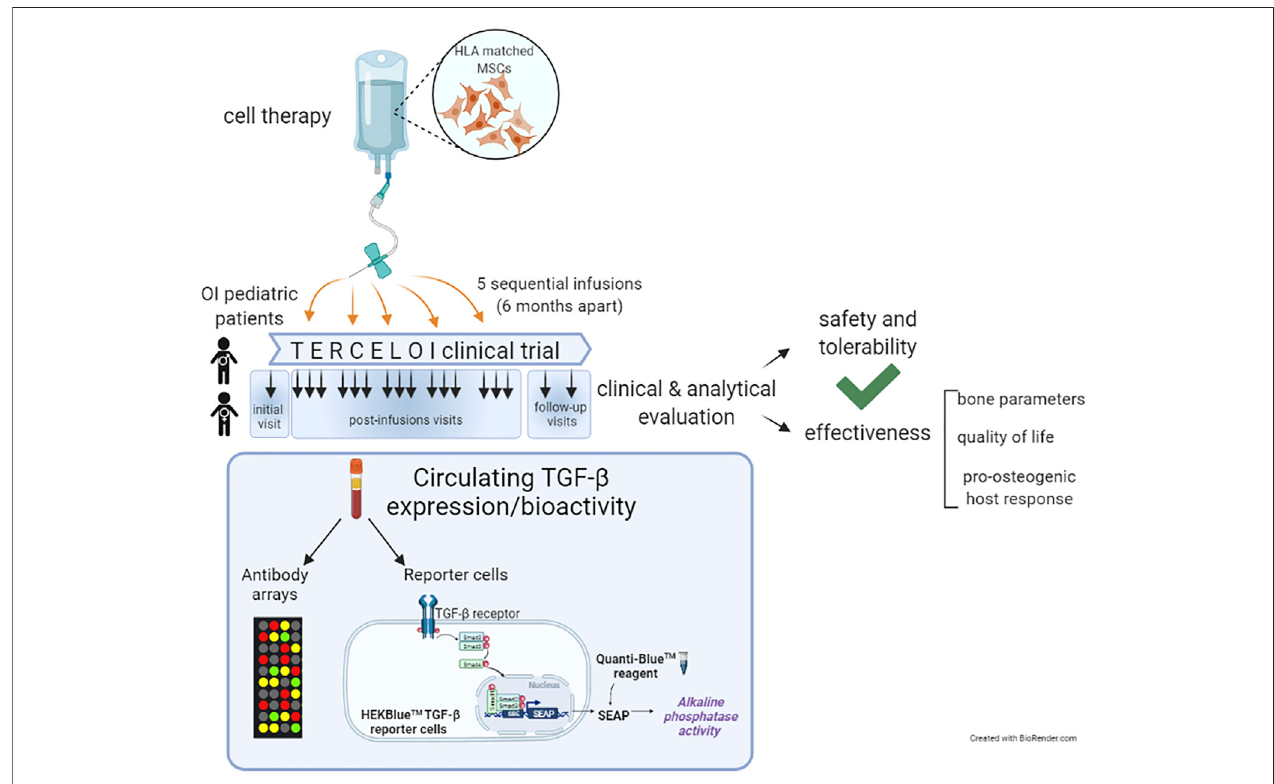
FIGURE1| SchematicdiagramillustratingTERCELOIclinicaltrialcellularinfusionsand thecurrentstudyofcirculating TGF- β expressionand bioactivity inpatients ’ sera collected before (basal serum) and after the fi ve consecutive MSCs infusions. The post-infusions sera included those collected 1 week (1w), 1 month (1 m) and 4 months (4 m) after each cell infusion, as well as the follow-up sera, collected 1 year and 2 years after the last cell infusion.